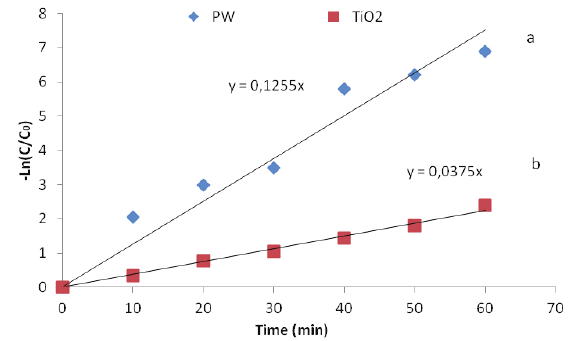
Figure 11: Pseudo fi rst order kinetic of MB degradation for: a) praseodymium tungstate (PW), b) TiO